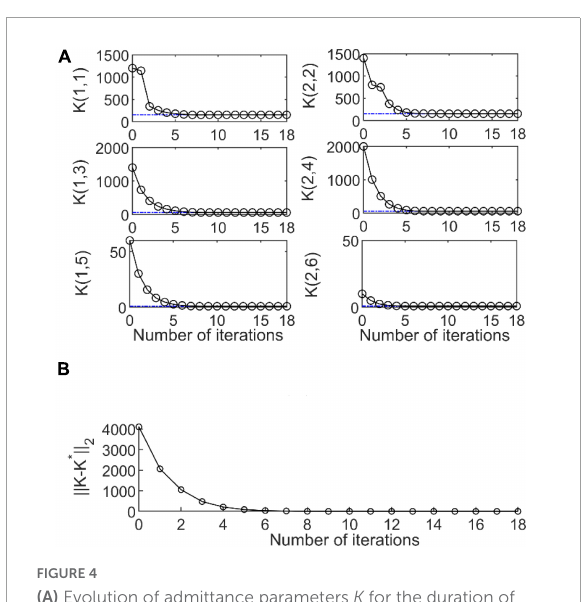
FIGURE4 (A) Evolution of admittance parameters K for the duration of simulation, Blue lines are the optimal admittance parameters K* obtained with the linear quadratic regulator (LQR) algorithm for a specific human control dynamic model. Black lines are the results obtained by reinforcement learning (RL) method under unknown human dynamics; K ( i , j ) is the element of K , i , and j are index of row and column, respectively. (B) Convergence of || K − K* || 2